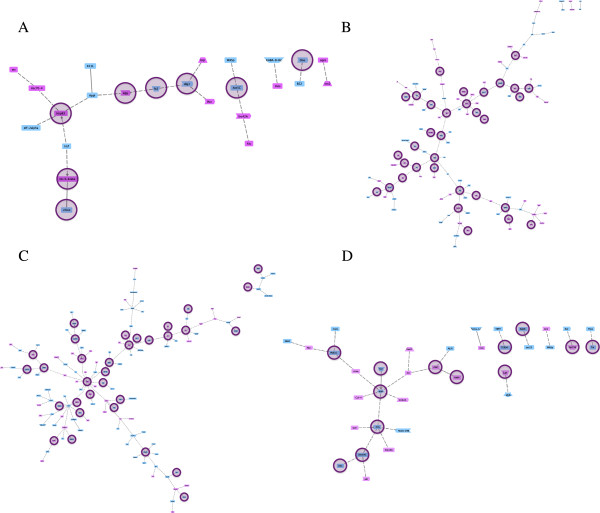
Predicted co-citation networks from Grozinger et al.[23]gene lists for 1-, 2-, 3-, and 4-day-old workers (A-D, respectively). Each node is a gene and each edge is a potential interaction between two genes. Pink genes are up-regulated in workers exposed to queen mandibular pheromone (as determined in the original study), and blue genes are correspondingly down-regulated. Genes highlighted with a circle are enriched for biological processes pertaining to ‘reproduction’ (GO:0000003).